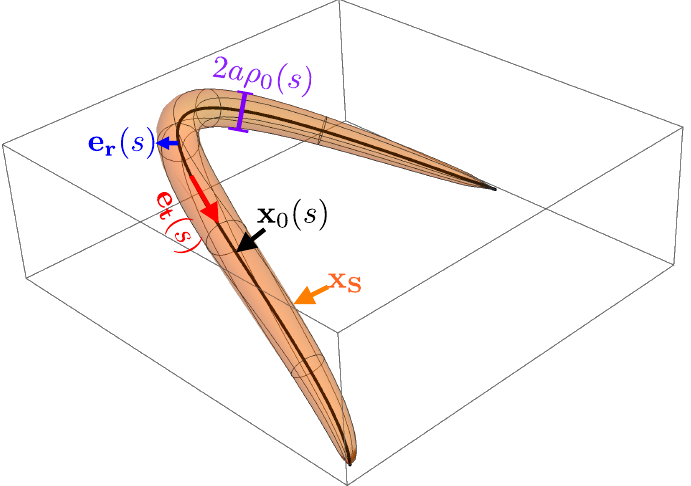
Figure 1. Example geometry of a slender body. x 0 ( s ) is the centreline, x S is the surface, e t ( s ) is the tangent to the centreline, e r ( s ) is a radial vector perpendicular to the tangent and 2 a ρ 0 ( s ) represents the thickness at s